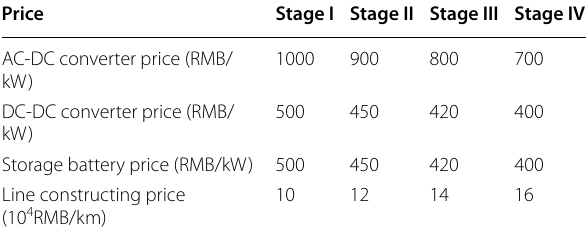
Table 9 Investment cost of multi-stage planning in Case VI Price